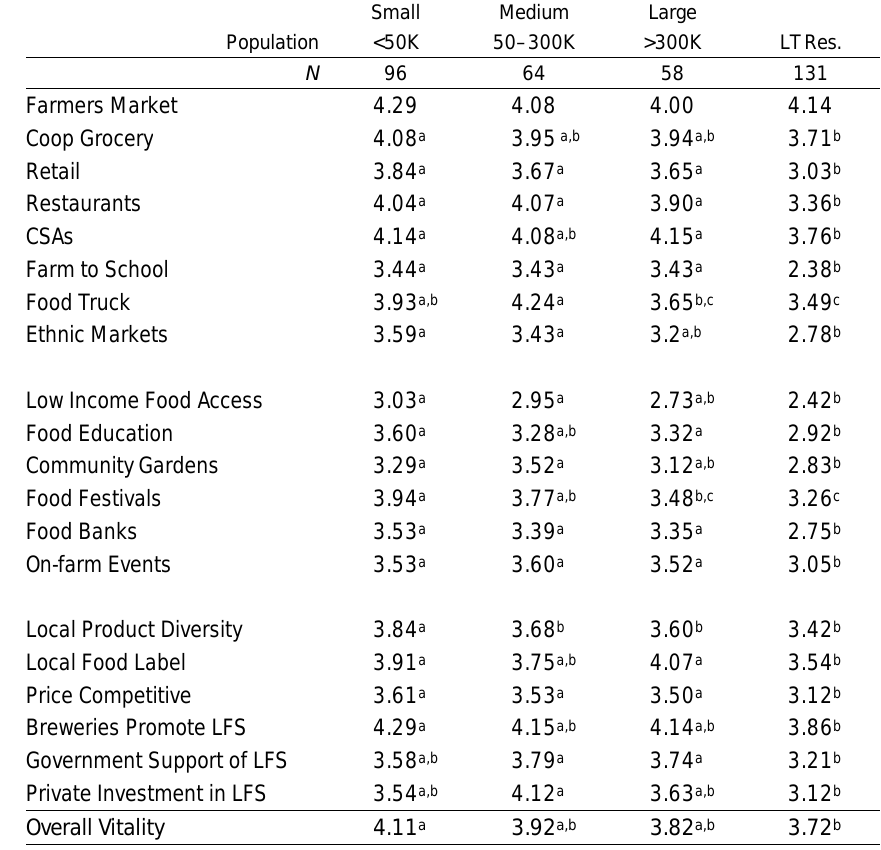
Table 3. Resident Perceptions of Lexington Based on Previous Community